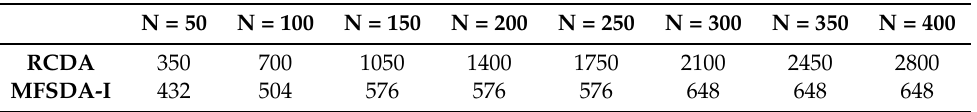
Table 7. Data length comparison between MFSDA-I and RCDA based on Wind Direction of the TAO project (units: